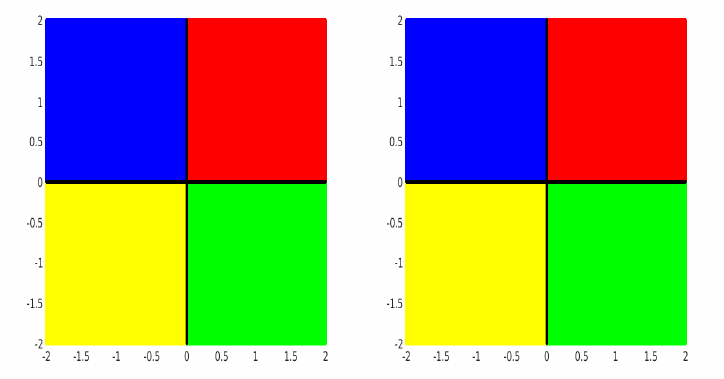
Figure 6. Dynamical plane of the methods (3) (left) and (4) (right) with basins of attraction for Example